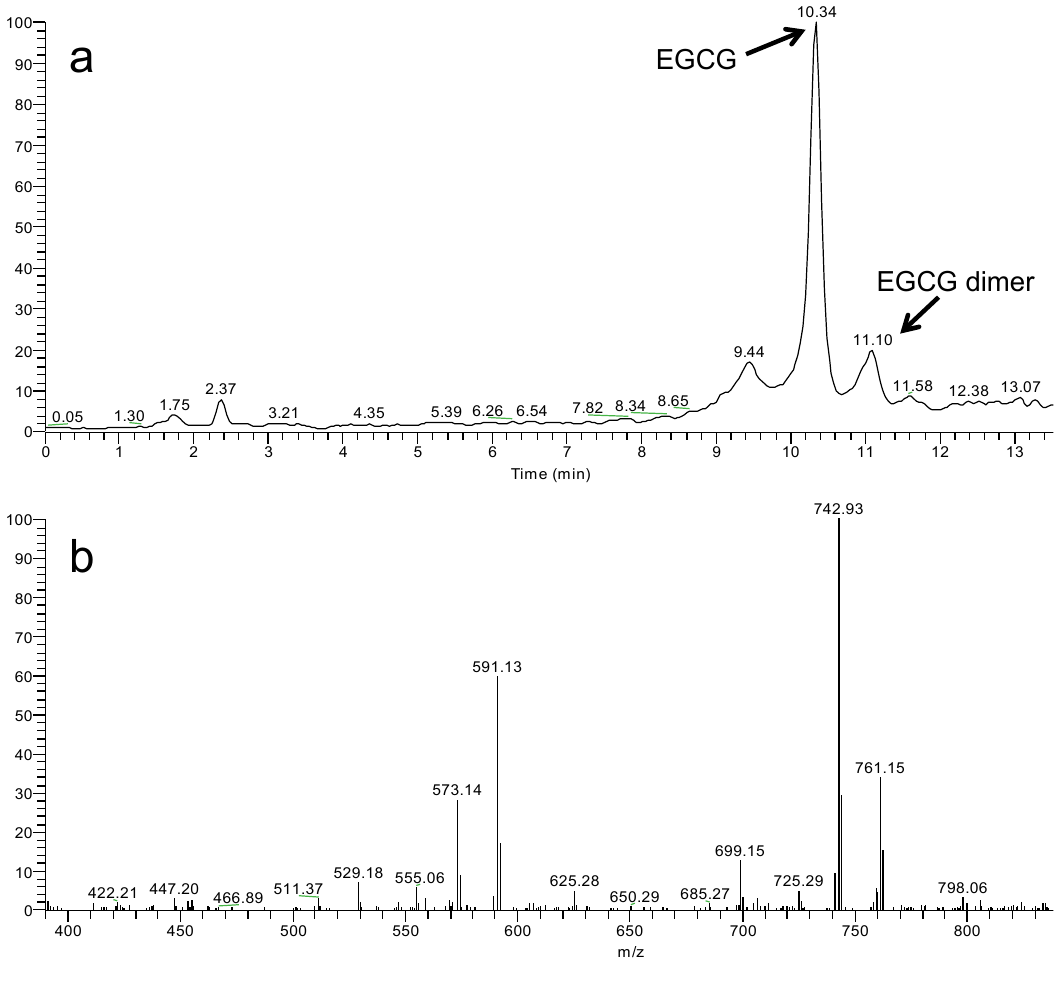
Figure 3. ( a ) Extracted ion current trace obtained by HPLC-ESI-MS/MS analysis of a cream preparation irradiated with the solar simulator. ( b ) ESI negative HPLC-MS/MS spectrum of EGCG dimer peak: characteristic daughter ions from CID fragmentation of − [M − H] at m/z 913 are 573.1, 591.1, 742.9 and 761.1 m/z .